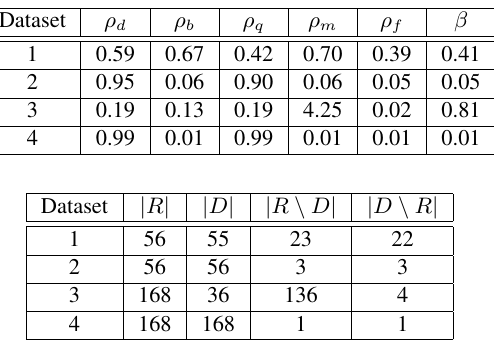
Table 1: Quality measures and statistics for Dataset 1 - 4 .